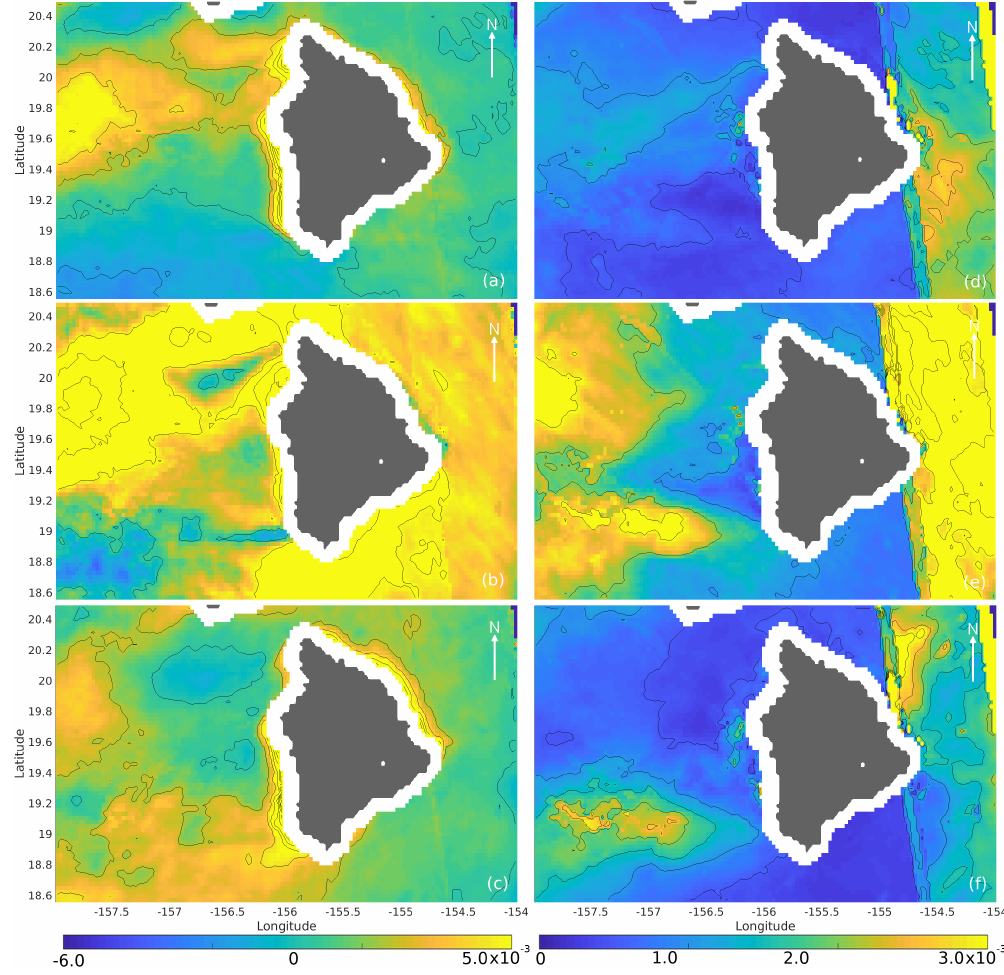
Figure 7. The average difference between linear values of measured ASCAT σ 0 and HRCM predicted σ 0 shown for fore ( a ), mid ( b ), and aft ( c ) beams. Corresponding normalized standard deviation of the difference values are shown to the right in panels ( d – f ). The land is shown in gray and the land contamination buffer is shown in